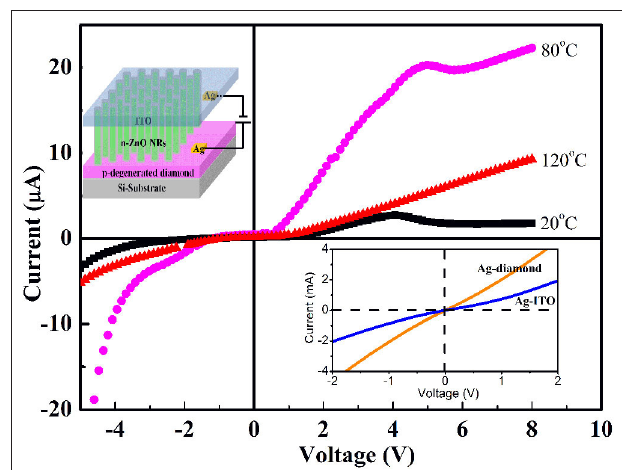
FIGURE 2 | I–V plots of the n-ZnO NRs/p-degenerated diamond at different temperatures of 20 ∼ 120 ◦ C. The top inset shows the schematic diagram of the n-ZnO NRs/p-degenerated diamond heterojunction device. The bottom inset is the linear of I–V characteristics of ohmic contacts of Ag/ITO and Ag/p-degenerated diamond.